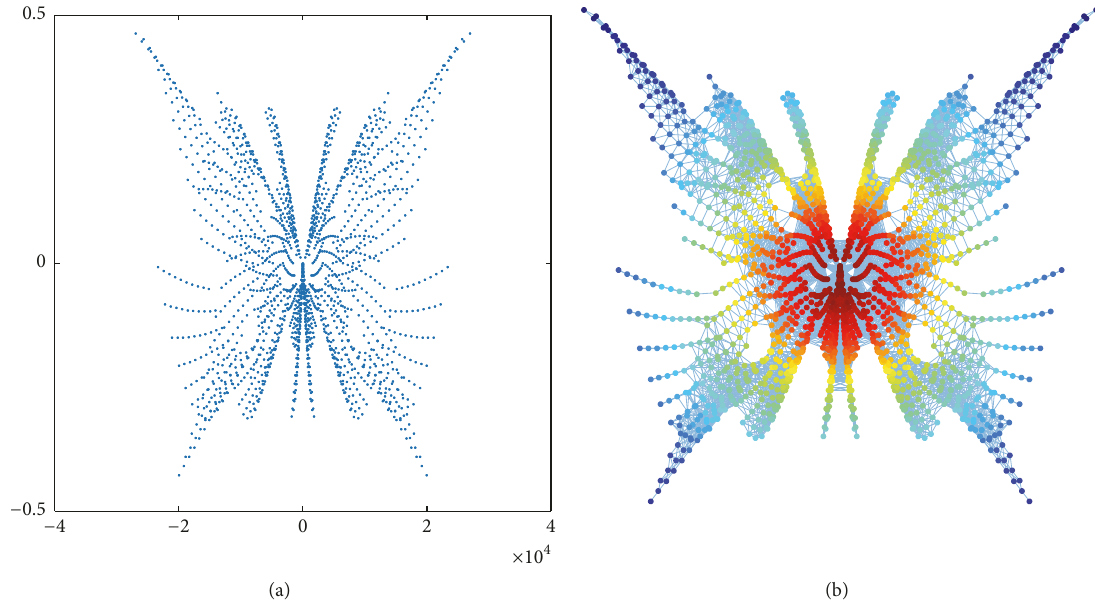
Figure 4: Illustration of the process to build a spatial network based on integer-function deconstruction. (a) Distribution of the points obtained from the transform 𝑇 1 on a square. (b) Construction of the spatial graph using a connection radius 𝑅 = 0.075 with 𝑛 = 2,000 points and coloring the nodes according to their closeness centrality.